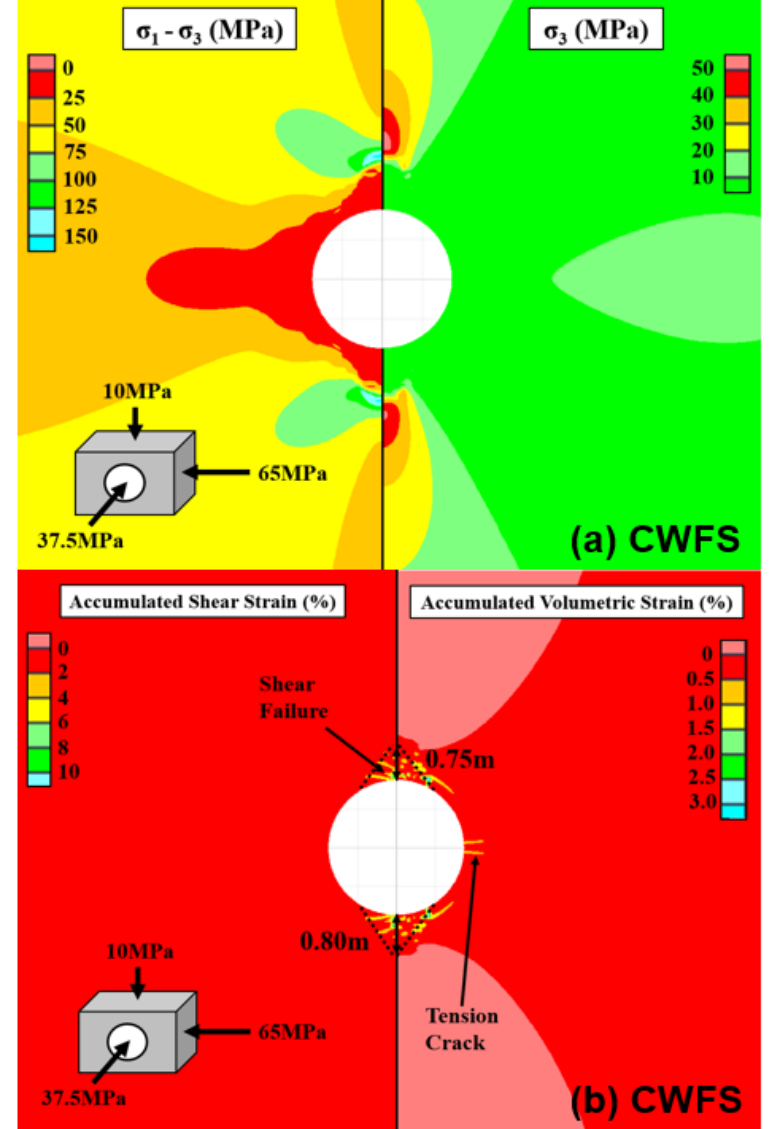
Figure 13. Instantaneous response from the CWFS analysis showing ( a ) in–situ stresses and ( b ) shear and volumetric strain with depth of yield and typical “notch”-type failure.